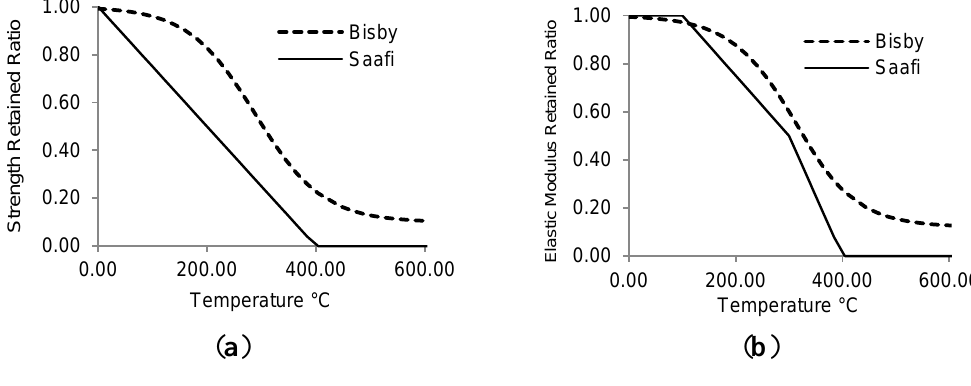
Figure 1. Comparing Bisby’s and Saafi’s models; ( a ) Strength reduction; ( b ) Elastic modulus degradation for GFRP at elevated temperatures.